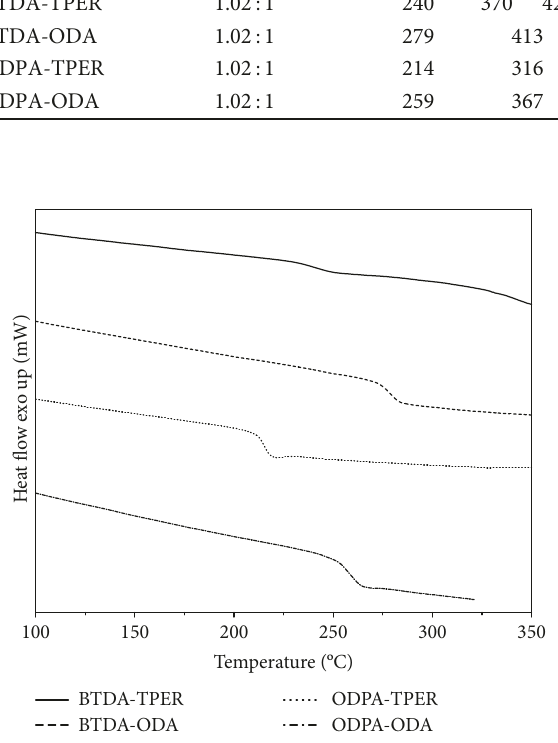
Figure 2: Glass transition curves of PI.